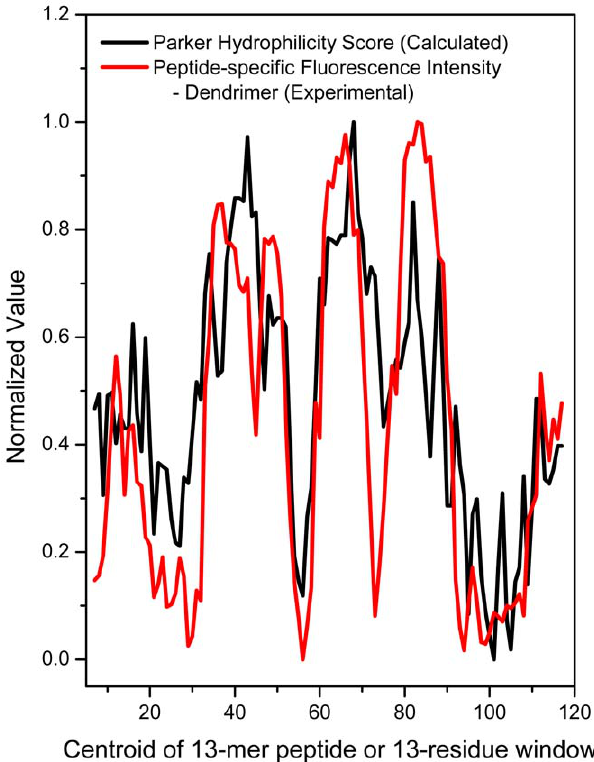
Figure 8. Correlation of observed and predicted epitopes. Overlay of normalized mean background-corrected fluorescence in- tensity (13-mer peptide-specific immunoreactivity) of the dendrimer 8- adjuvanted rabbit sera and normalized Parker Hydrophilicity parameter computed with a moving window of 13 residues. selective induction of TLR7-driven IFN- a , but not of IFN- c (Fig. 3), or proinflammatory cytokines such as TNF- a , IL-1 b , and IL-6 (Fig. 4).